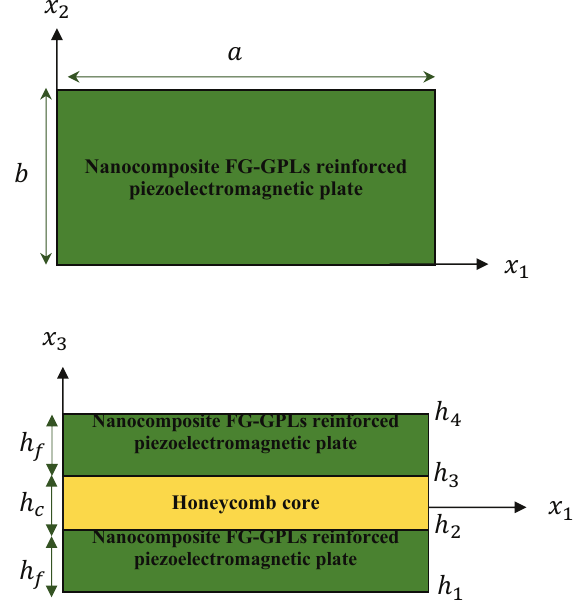
Figure 1. The scheme of three-layered rectangular sandwich plate with nanocomposite FG GPLs- reinforced piezoelectromagnetic with a honeycomb